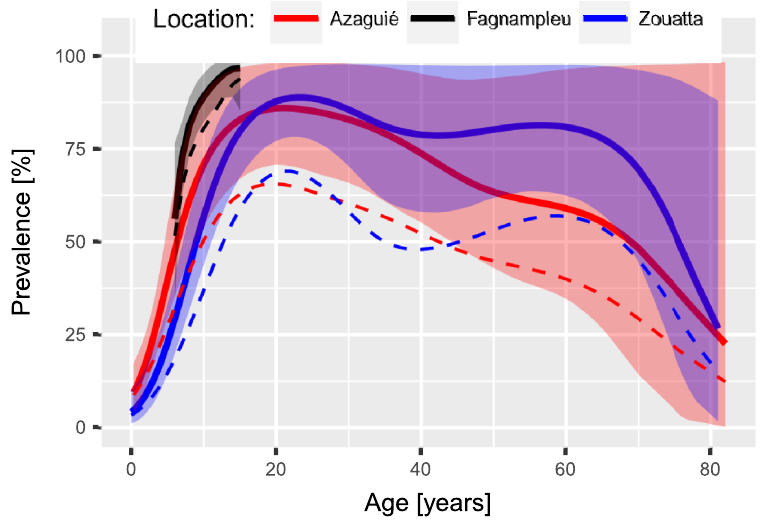
Fig 2. Prevalence of S. mansoni infection in relation to age for three studies in Coˆte d’Ivoire, including 95% BCI indicated by shaded areas, and observed prevalenceas dashed line.